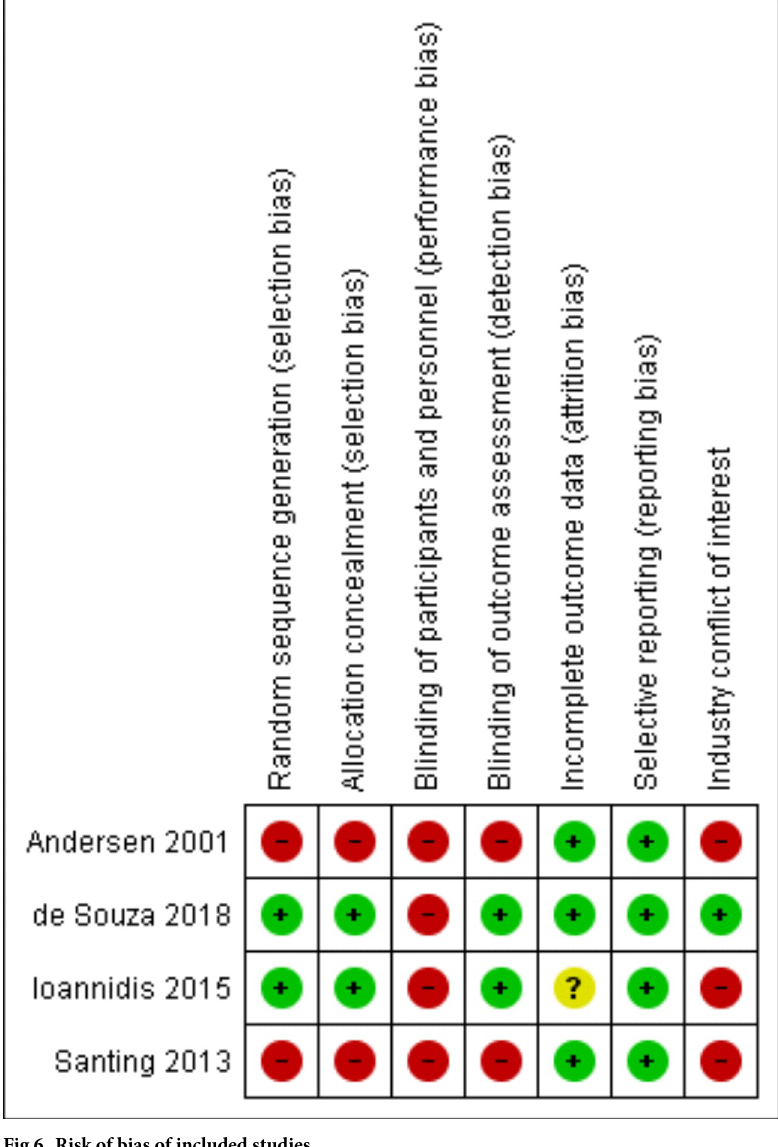
Fig 6. Risk of bias of included